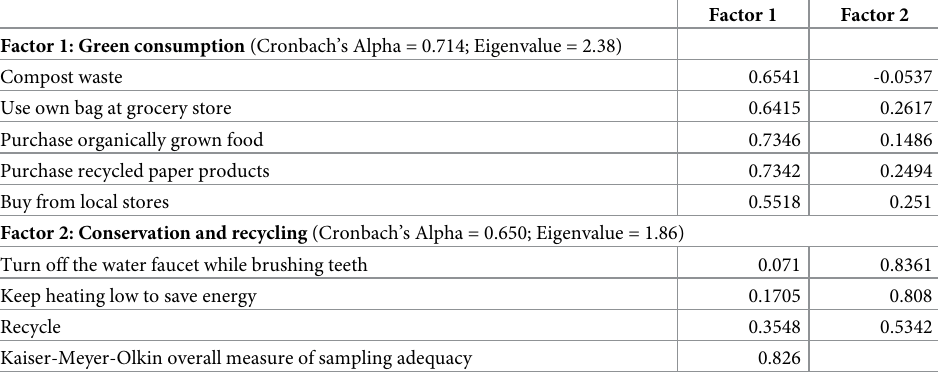
Table 3. Principal component factor analysis results for behavior survey